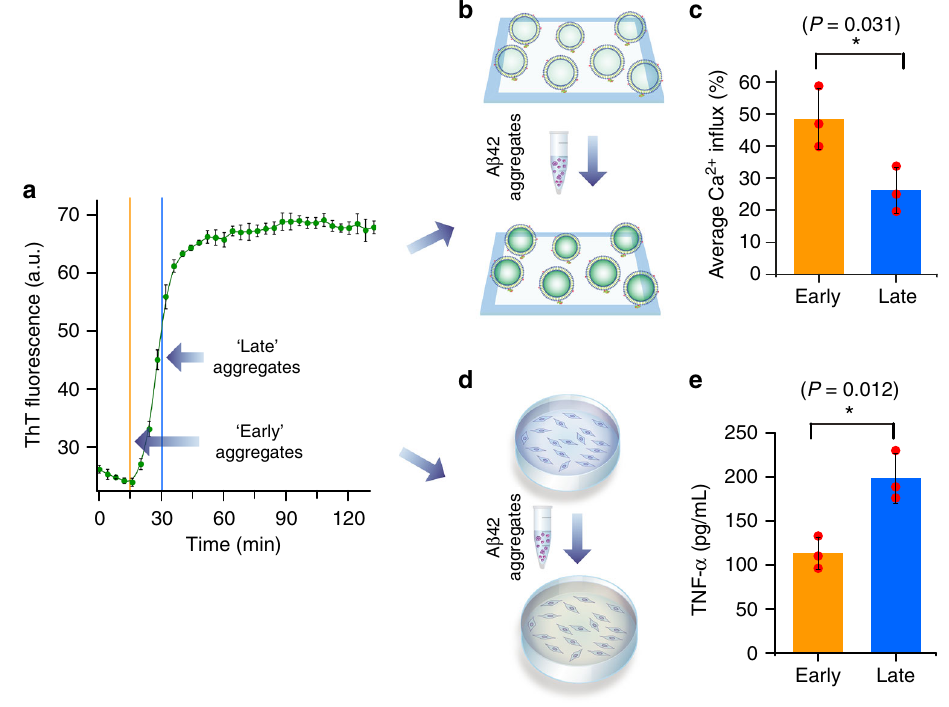
Fig. 1 Soluble A β 42 aggregates at different aggregation stages show different toxicity mechanisms. a The aggregation A β 42 was monitored by ThT fl uorescence. Each data point represents the mean of three independent biological repeats and its error bar the corresponding standard deviation. Aliquots containing A β 42 aggregates were taken from the aggregation reaction at two different time points — at the end of the lag phase (15 min, for ‘ early ’ soluble aggregates) and at the midpoint of the growth phase (30 min, for ‘ late ’ soluble aggregates). b The lipid bilayer permeability induced by A β 42 aggregates was measured by immobilizing on glass cover slides hundreds of nano-sized individual lipid vesicles in the presence of a Ca 2 + -sensitive dye. If the aggregates disrupt the integrity of the lipid bilayer, Ca 2 + from the external medium enters into individual vesicles to a level that can be quanti fi ed using highly sensitive total internal fl uorescence microscopy (TIRF) measurements. c Early A β 42 aggregates cause a higher level of bilayer permeability than later A β 42 aggregates. The data were averaged over three biological repeats, with each repeat involving the analysis of 6000 individual lipid vesicles, the error bars represent standard deviation, and the statistical signi fi cance was calculated using a two-sample t -test. d The in fl ammatory response in microglia was quanti fi ed using an ELISA assay to measure the levels of secreted tumour necrosis factor alpha (TNF- ɑ ). e In contrast to the bilayer permeability assay, the late aggregates were more effective than the early aggregates. The data are averaged over three biological repeats, each repeat was averaged over three wells, each of which contained 200,000 to 300,000 BV2 cells, the error bars represent the standard deviation among the repeats, and the statistical signi fi cance was calculated using a two-sample t -test (unpaired). Data points for each biological replicate shown with red circles. Source data of a , c